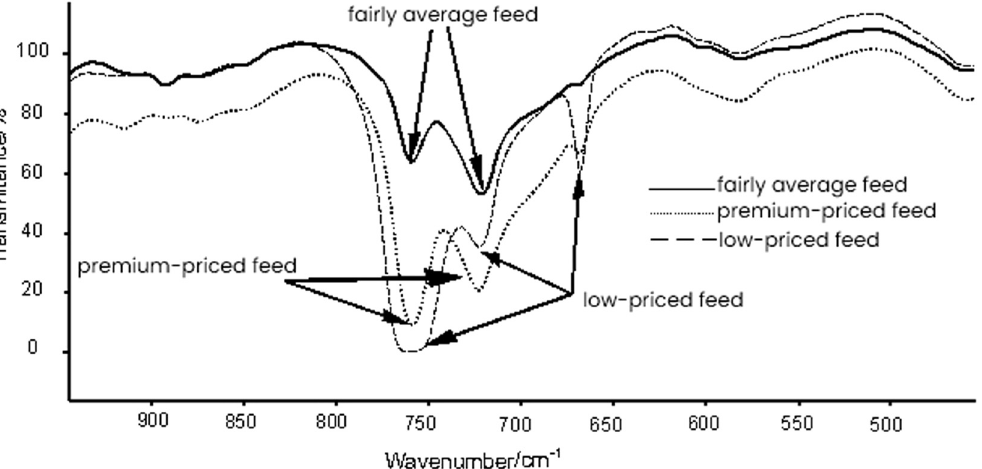
Figure 3: IR spectral region 900 – 500 cm − 1 extension registered for low - priced, fairly average priced and premium - priced cat feeds as a radiation transmittance against